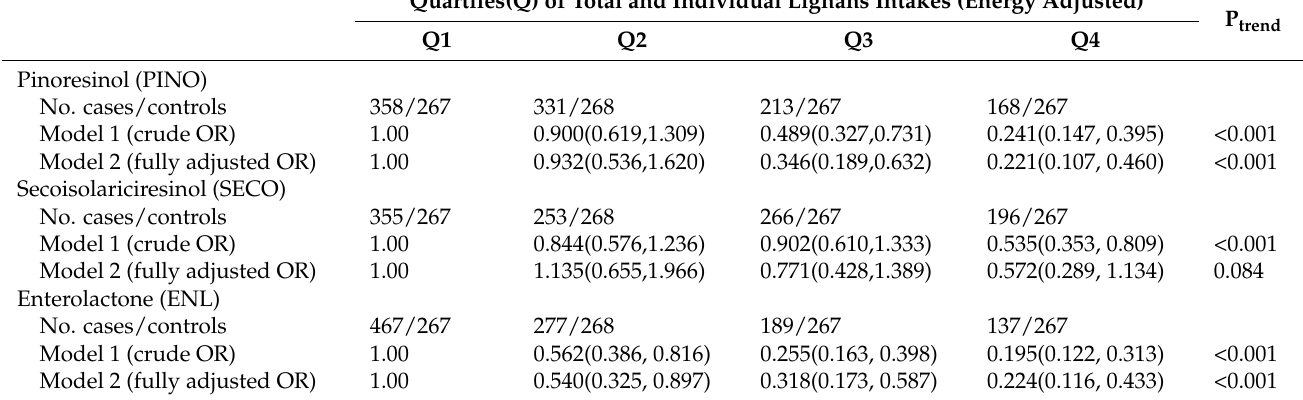
Table 3. Cont. Quartiles(Q) of Total and Individual Lignans Intakes (Energy Adjusted)